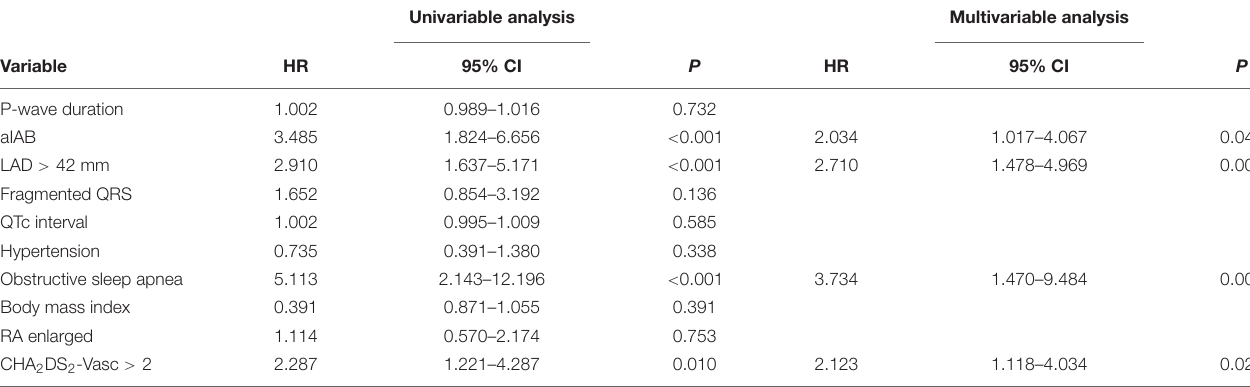
TABLE 3 | Univariable and multivariable Cox regression analysis for atrial fibrillation